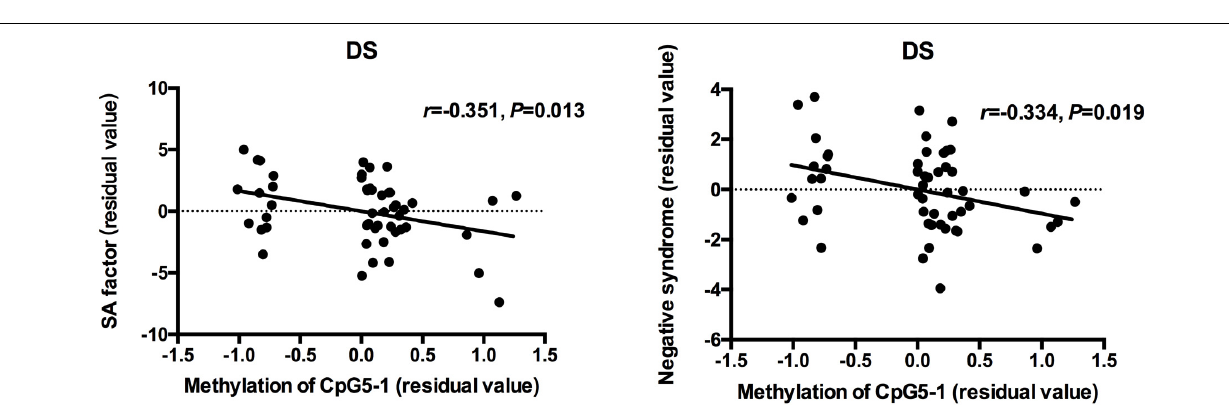
FIGURE 2 | Correlation between DNA methylation of MMP9 and assessment of clinical symptoms. The points of the scatter plot represented residual value of DNA methylation of CpG5-1 and subscale of SANS and BPRS after controlled age and CPZ-equivalent as covariates in DS